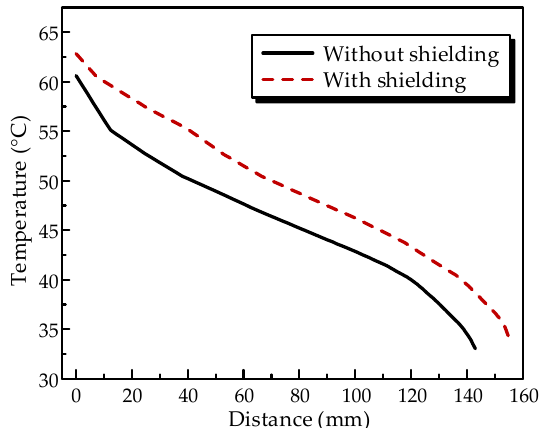
Figure 5. Surface temperature of the spacer with different geometry models.